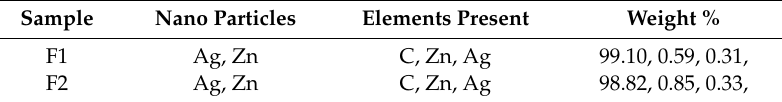
Table 3. Elemental analysis and wt.% of elements by EDX.